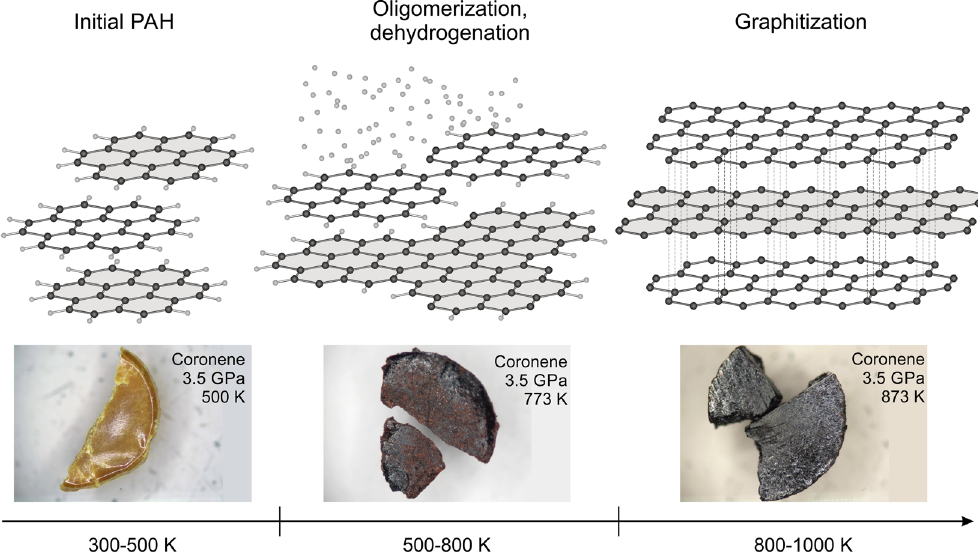
Figure 6. PAHs oligomerization and carbonization mechanism at high pressure and temperature. The steps for the PAHs carbonization can be divided into two stages: (1) PAH dehydrogenation and successive fusion of the initial hydrocarbon molecules through C-C bond formation (500–800 K) - change of color from white or yellow to yellow, red or brown; and (2) decrease of intermolecular distances and polycondensation of benzene rings (800–1000 K) - change of color from yellow, red or brown to dark brown or